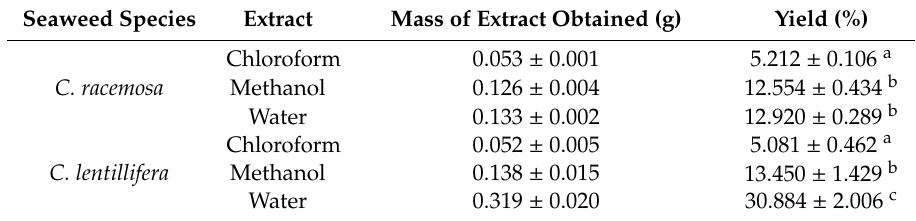
Table 1. Yield percentages of seaweed extracts from each seaweed species.